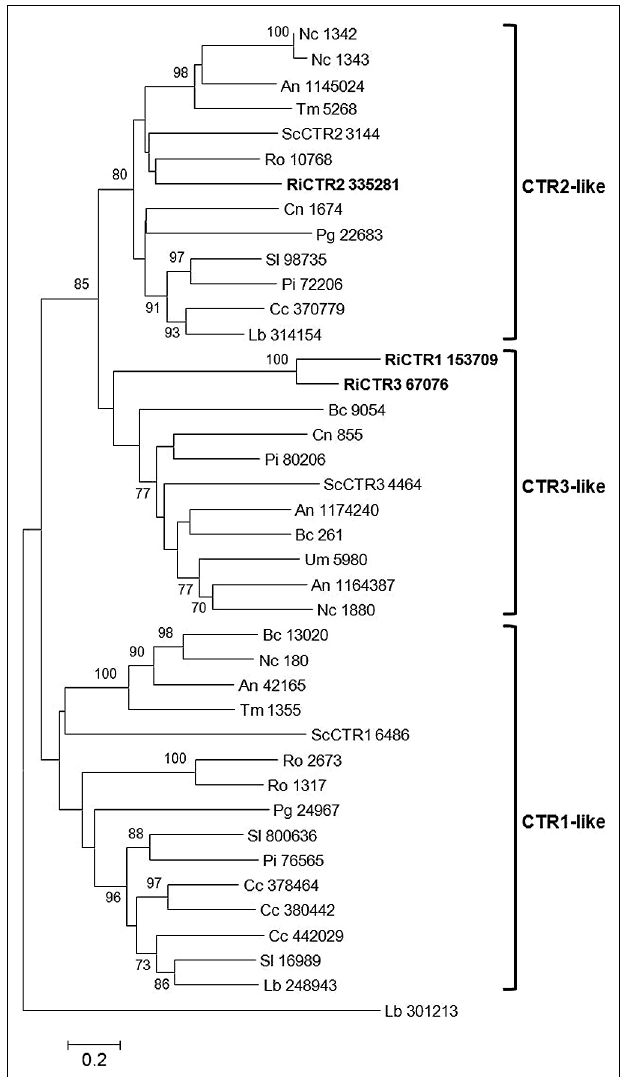
FIGURE 2 | Phylogenetic relationships of the Rhizophagus irregularis copper transporters (CTR) with homologous sequences from selected species representative of the major fungal phyla. The Neighbor-Joining tree was created with MEGA 6. Protein JGI identification numbers are indicated. R. irregularis genes are shown in bold. Organisms: An, Aspergillus niger ; Bc, Botrytis cinerea ; Cc, Coprinopsis cinerea ; Cn, Cryptococcus neoformans ; Lb, Laccaria bicolor ; Nc, Neurospora crassa ; Pi, Piriformospora indica ; Pg, Puccinia graminis ; Sc, Saccharomyces cerevisiae ; Sl, Suillus luteus ;Tb, Tuber melanosporum; Ri, Rhizophagus irregularis ; Ro, Rhizopus oryzae ; Um, Ustilago maydis . Bootstrap values above 70 and supporting a node used to define a cluster are